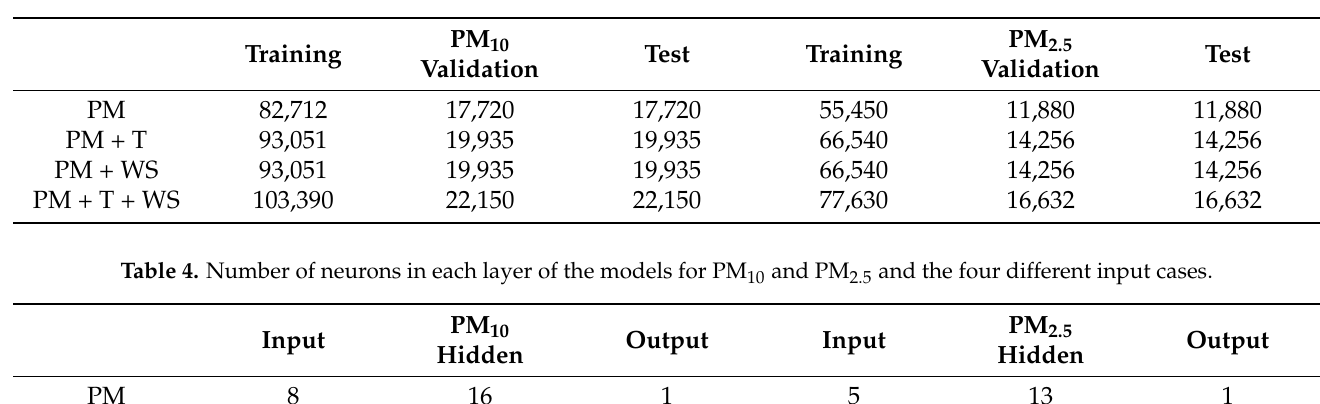
Table 3. Number of data points in each subset for PM 10 and PM 2.5 and the four different input cases.